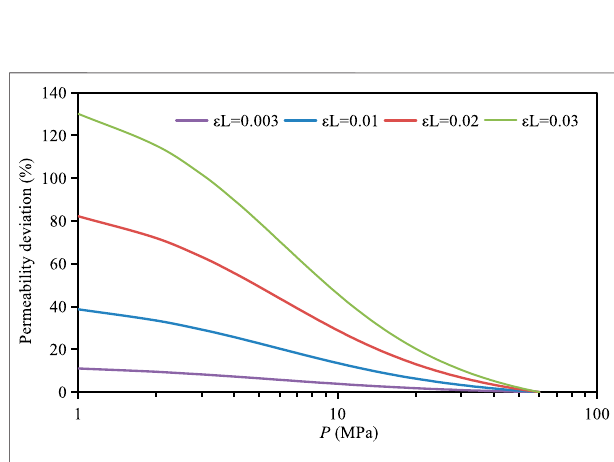
FIGURE 6 | Apparent permeability deviation versus the pore pressure at different Langmuir strains.